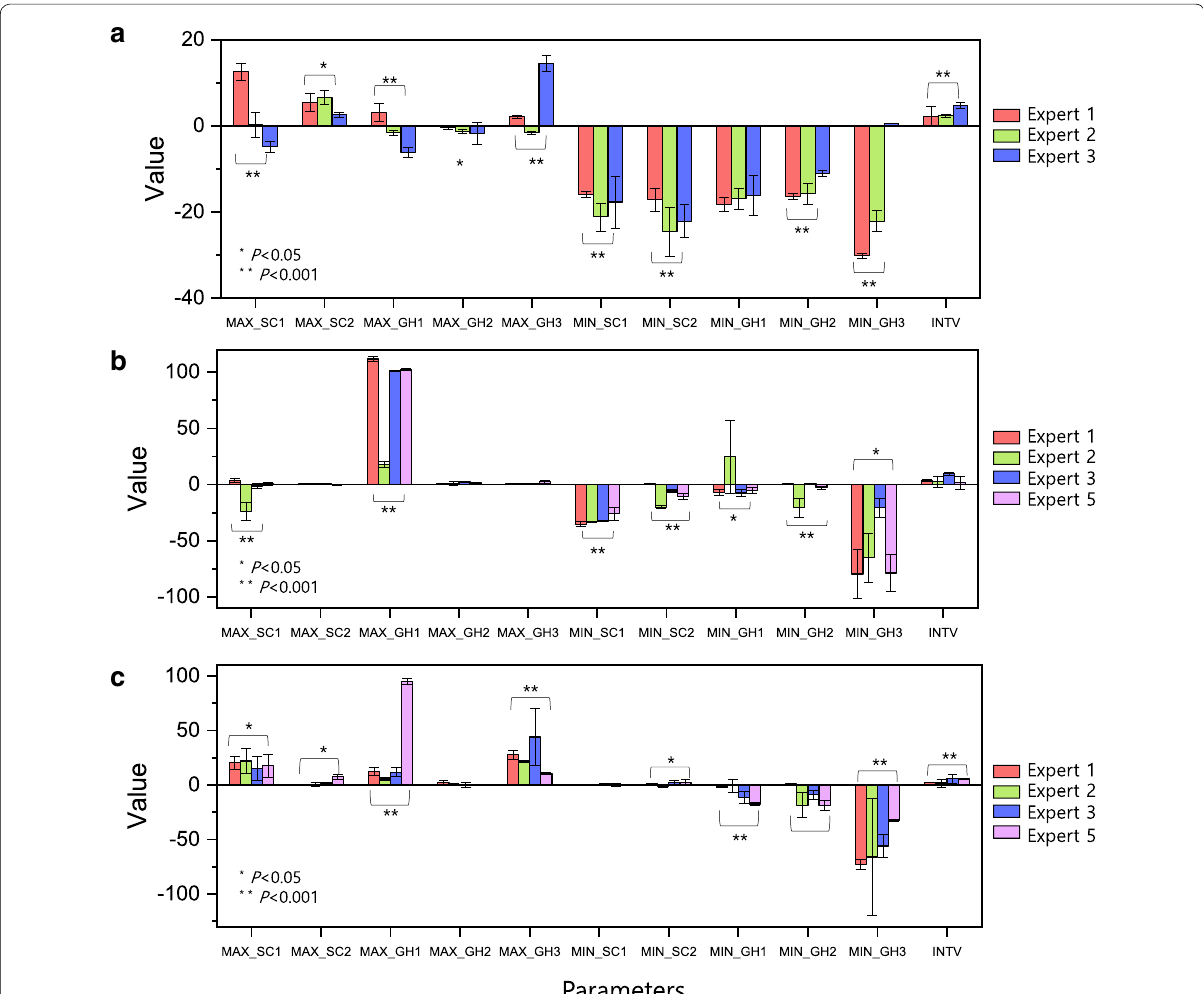
Fig. 11 Results of statistical analysis with respect to all 11 parameters, a elevation and depression (ED); b extension and flexion (EF); c lateral‑ and medial‑ rotation (LM) exercise from the experts. The MAX and MIN with underscore represent the maximum and minimum joint angles, while INTV indicates the interval of each